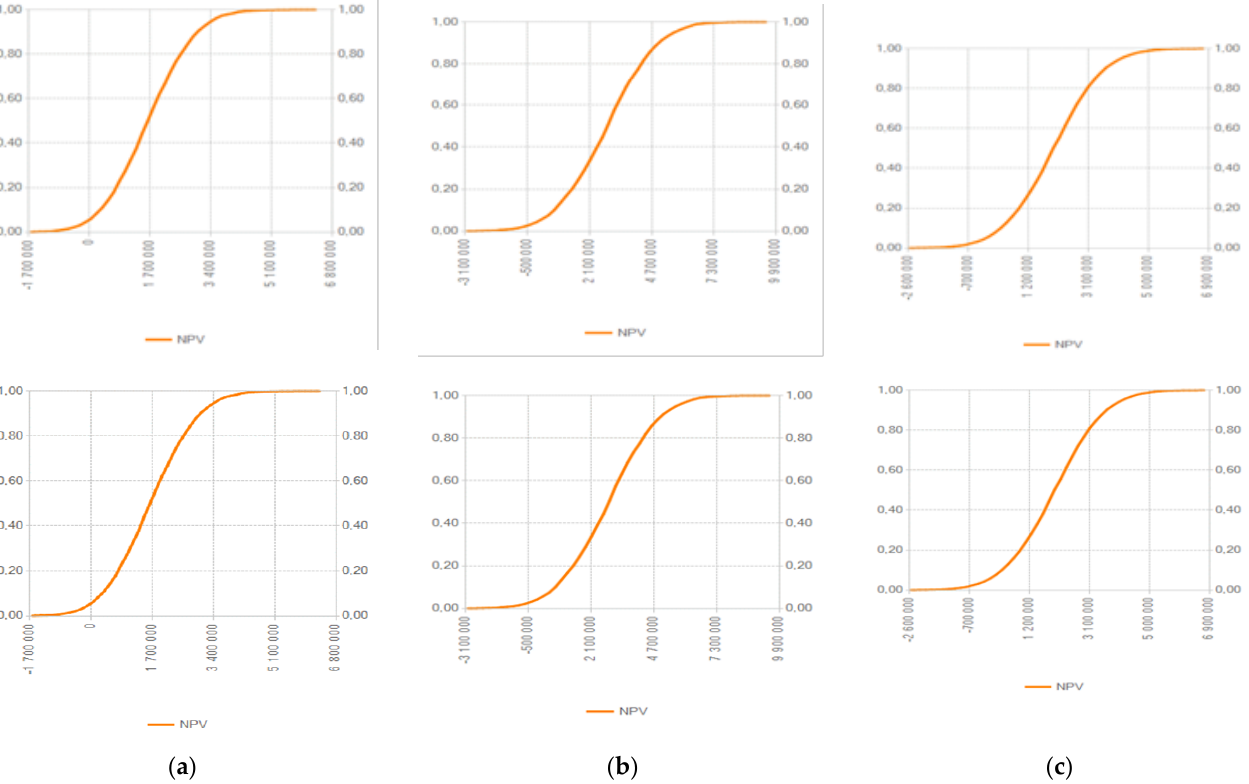
Figure 1. Monte Carlo simulation result Net Present Values (NPV)s—cumulative distribution function.